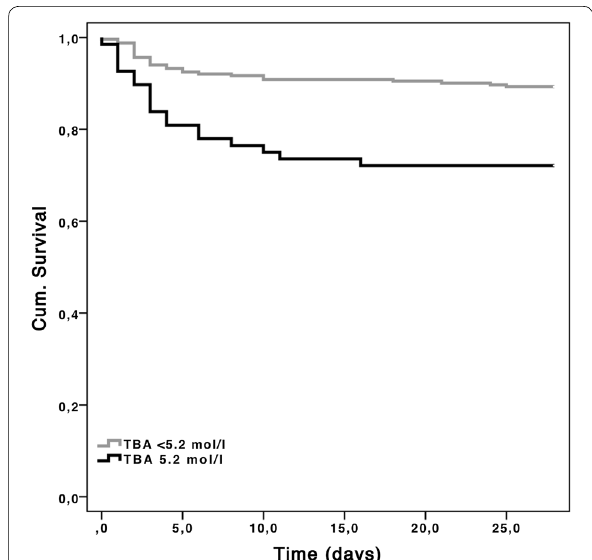
Fig. 3 Kaplan–Meier’s plot of 28-day survival. 28-day survival rate was significantly lower in patients with TBA (total bile acids)